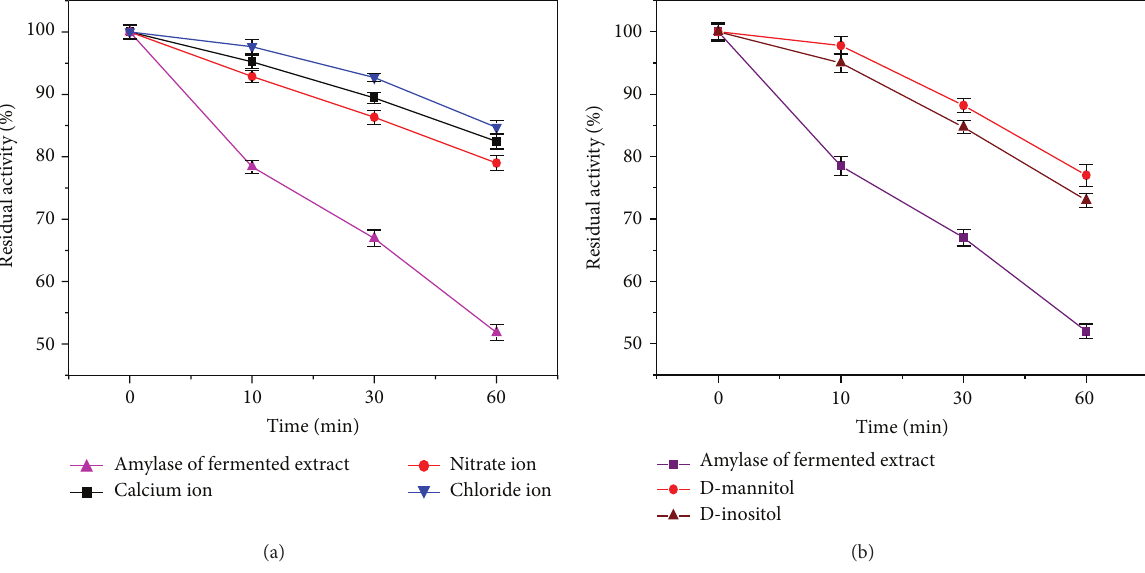
Figure 7: Percentage residual activity of amylase in absence and presence of ions and sugar alcohols